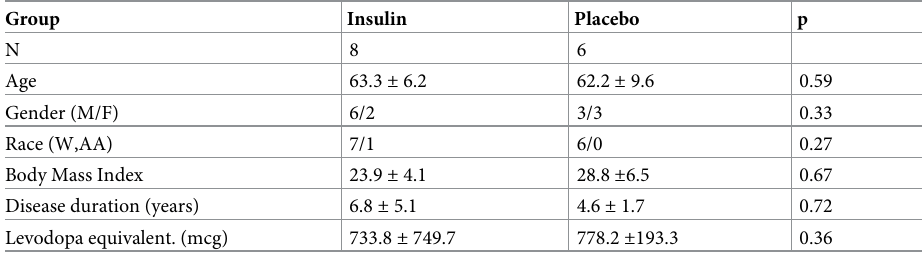
Table 1. Demographic characteristics of study population.